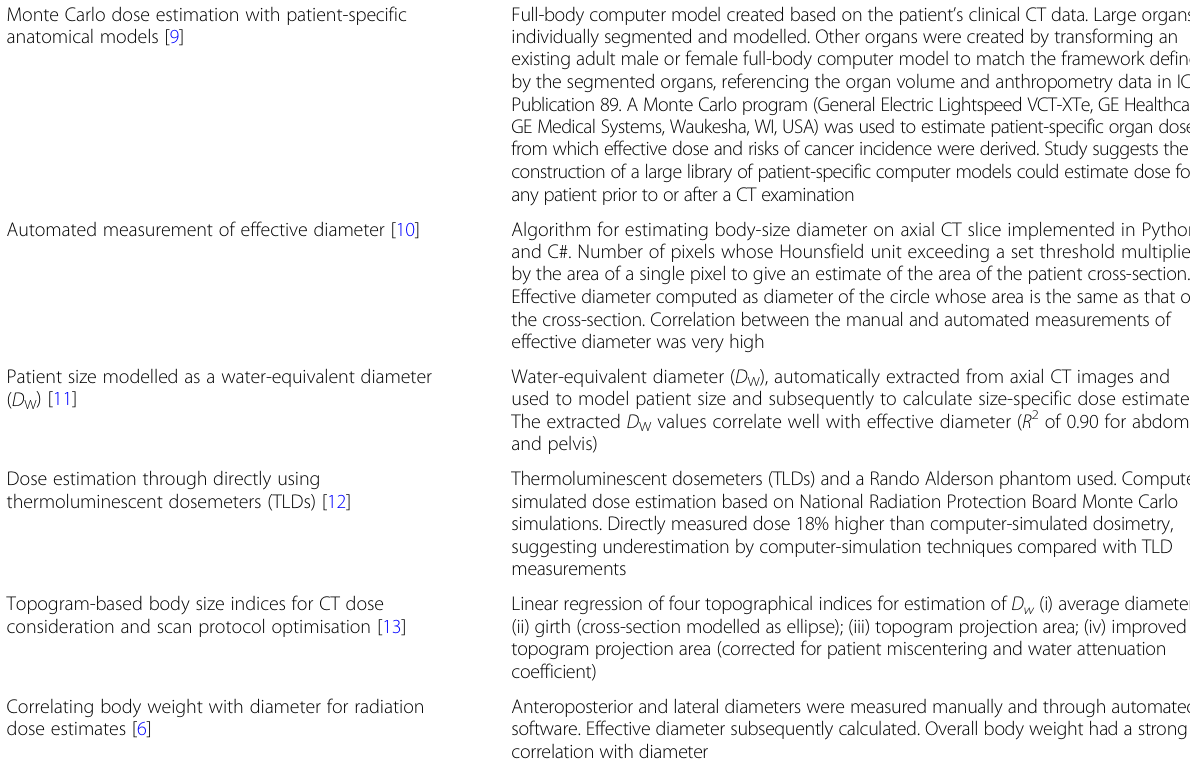
Table 4 Examples of dose estimation on abdominal computed tomography (CT) Monte Carlo dose estimation with patient-specific Full-body computer model created based on the patient ’ s clinical CT data. Large organs anatomical models [9] individually segmented and modelled. Other organs were created by transforming an existing adult male or female full-body computer model to match the framework defined by the segmented organs, referencing the organ volume and anthropometry data in